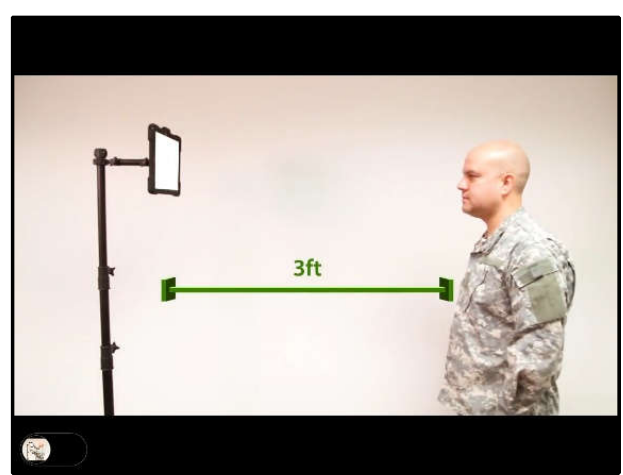
Figure 3. Instructional video page.